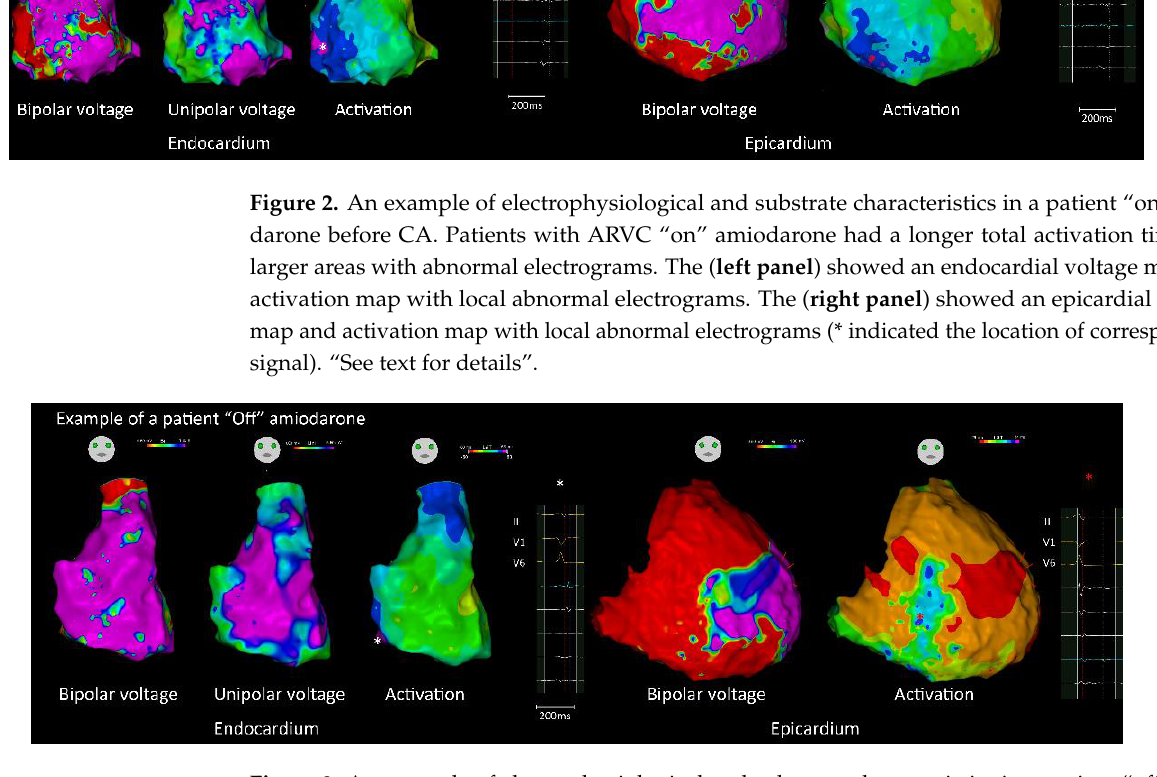
Figure 3. An example of electrophysiological and substrate characteristics in a patient “off” amio- darone before CA. The ( left panel ) showed an endocardial voltage map and activation map with local abnormal electrograms. The ( right panel ) showed an epicardial voltage map and activation map with local abnormal electrograms (* indicated the location of corresponding signal) . “See text for details” .